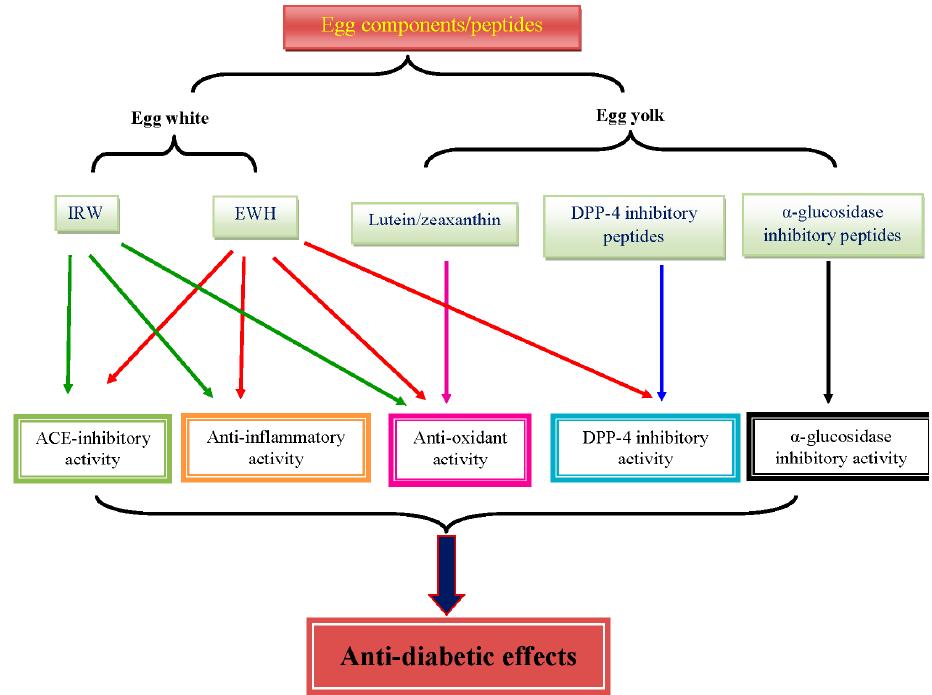
Figure 1. Major bioactivities of egg components and egg-derived peptides that possibly contribute to the benefits in T2D.